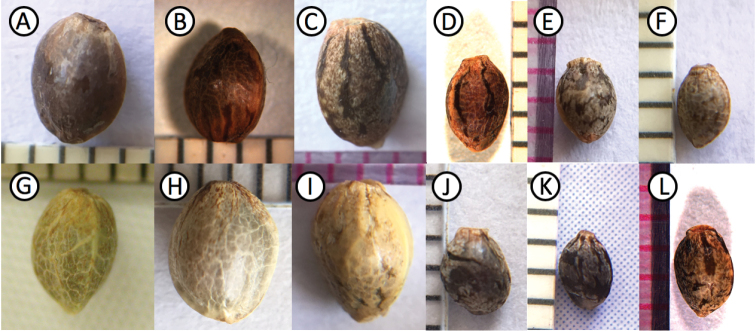
Representative achenes of four varieties Aindica, Rajshahi (Bangladesh), Clarke 1877 (BM) Bindica, Coimbatore (India), Bircher 1893 (K) Cindica, South Africa, Hillig 1996; (IND) Dhimalayensis neotype Ehimalayensis, Bareilly (India), Roxburgh 1796 (K). Fhimalayensis, East Bengal (Bangladesh) Griffith 1835 (GH) Gafghanica neotype Hafghanica epitype Iafghanica Yarkant (Xīnjiāng), Henderson 1871 (LE) Jasperrima lectotype Kasperrima Nuristān (Afghanistan), Street 1965 (F) L Kailiyskiy Alatau (Kazakhstan), Semenov-Tyan-Shansky 1857 (LE).